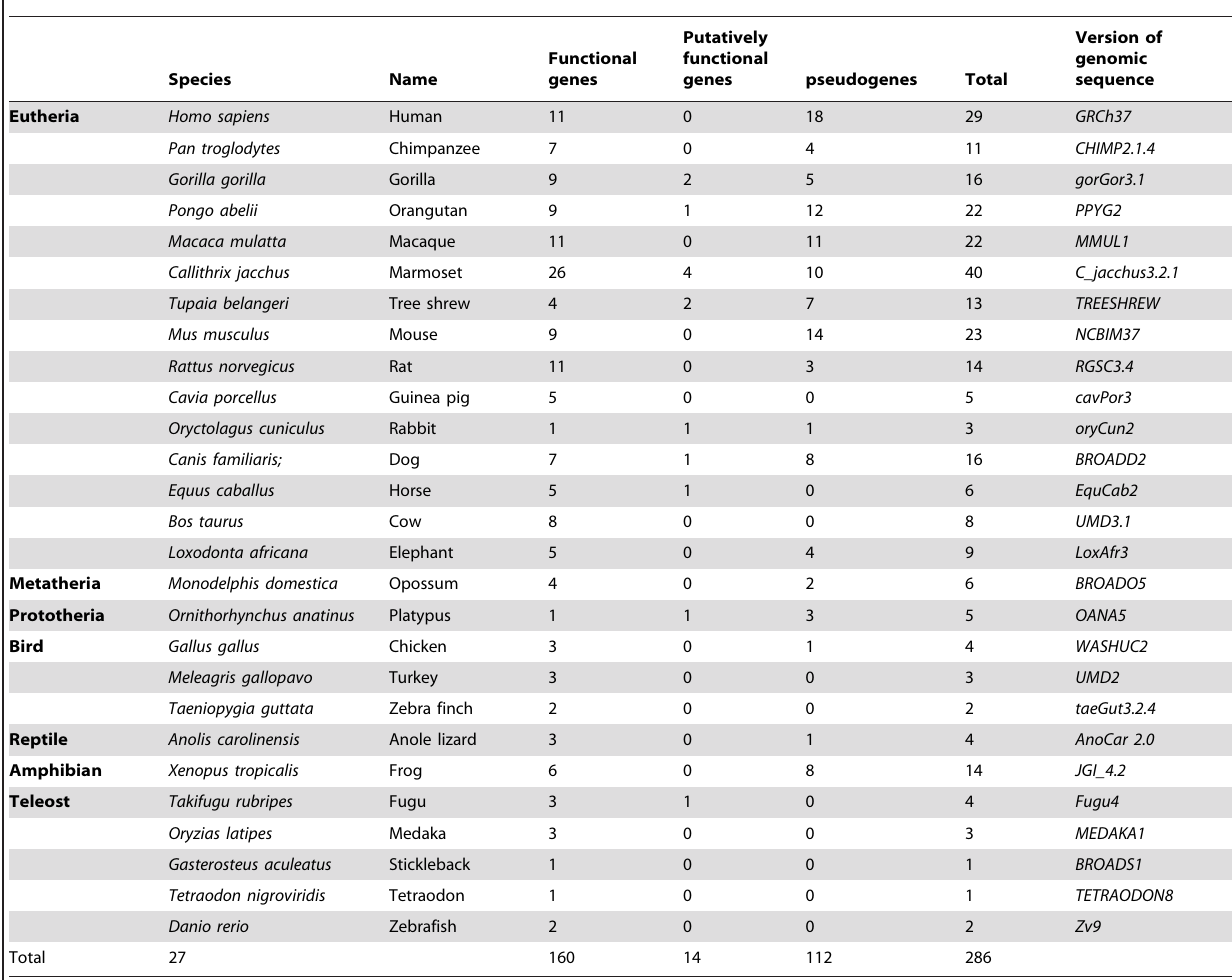
Table 1. Numbers of genes and pseudogenes in vertebrate IFITM